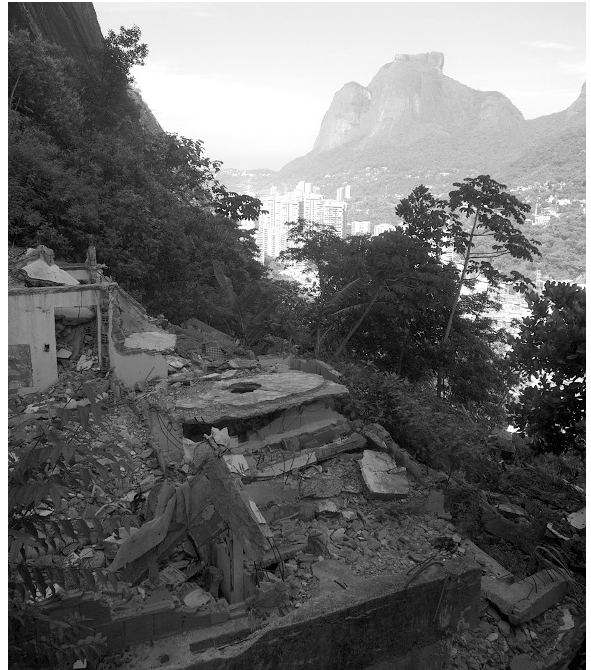
Figure 3. Demolished housing, Macega neighborhood of